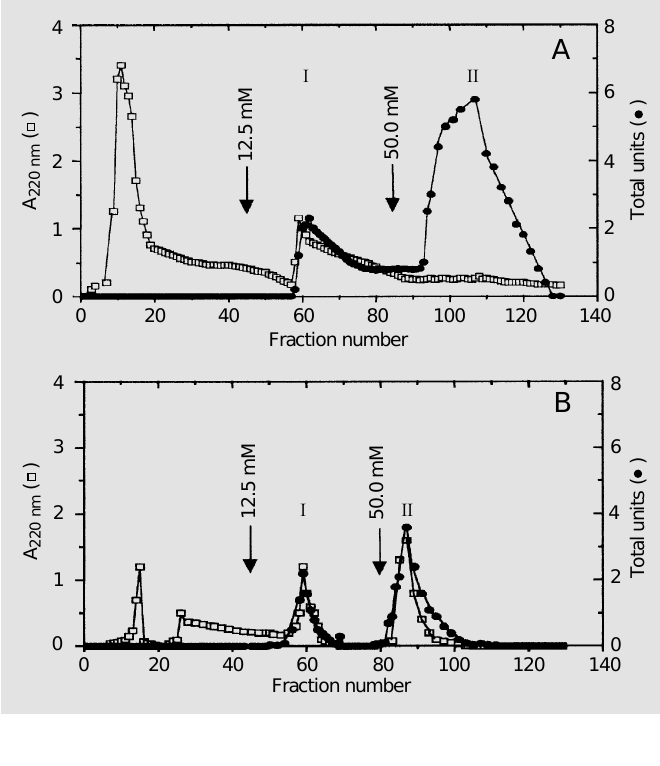
Figure 2 - Stepwise elution from DEAE-cellu- lose of constitutive alkaline phosphatases synthesized by the wild 74A strain of N. crassa grown in high-Pi medium at 30 o C, and supplemented with 44 mM acetate (A), pH 7.1, or 44 mM sucrose (B), pH 7.8, as the carbon source. After elution of non-absorbed proteins, enzyme elution was performed by the stepwise addition of 12.5 and 50.0 mM KCl in 10 mM Tris-HCl buffer, pH 8.8, contain- ing 40 mM MgSO 4 . For details, see Material